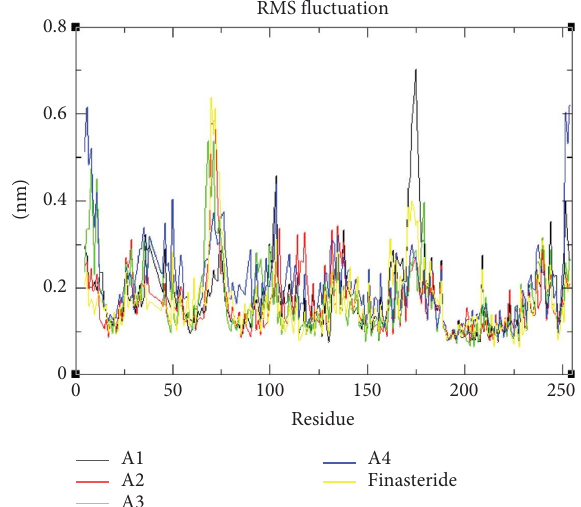
Figure 6: Te RMSF analysis of the 100ns trajectory of the protein- hit complexes with fnasteride as the control shows the contri- butions of the various amino acid residues towards achieving a stable protein–ligand